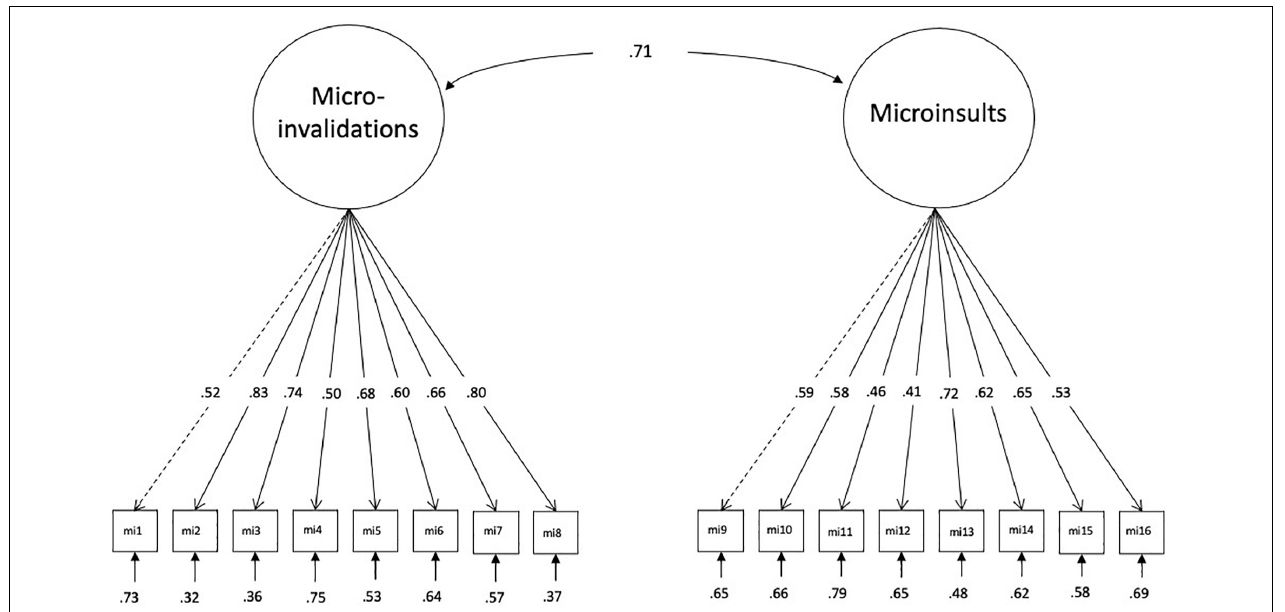
FIGURE 1 | Measurement model for the MIMI-16 in the construction sample. MIMI-16, Microinsults and Microinvalidations Scale, abbreviated items refer to Table 1 .